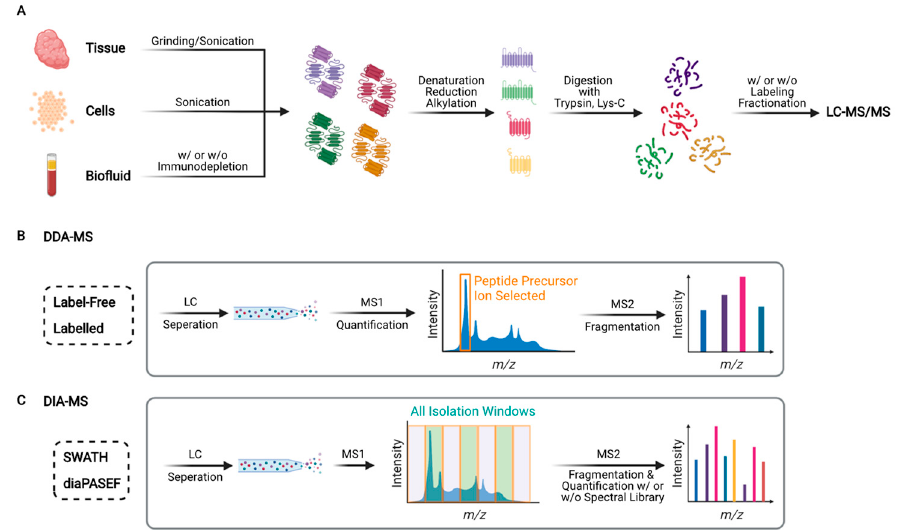
Figure 2. Schematic overview of bottom-up proteomics. ( A ) Typical workflow for global proteomic analysis. Proteins are extracted from tissues, cells, or biofluids, subsequently digested into peptides by an endoproteinase (e.g., trypsin or Lys-C), followed by label-free or isotope labeling-based quantitative proteomic analysis using liquid chromatography-tandem mass spectrometry (LC-MS/MS). ( B ) Schematic of data-dependent acquisition (DDA)-mass spectrometry (MS). Peptides are separated by reversed-phase LC and converted into positively charged gas-phase precursor ions, whose mass/charge ( m/z ) ratios are measured by MS. Peptide precursor ions with the highest intensities are isolated and broken into product (fragment) ions by MS/MS (also called MS2). ( C ) Schematic of data-independent acquisition (DIA)-MS. Representative methods include sequential window acquisition of all theoretic mass spectra (SWATH) and data-independent acquisition parallel accumulation-serial fragmentation (diaPASEF). Unlike DDA-MS, DIA-MS acquires MS/MS scans with wide isolation windows (e.g., 25 m/z ) that do not target any particular peptide precursor ions.